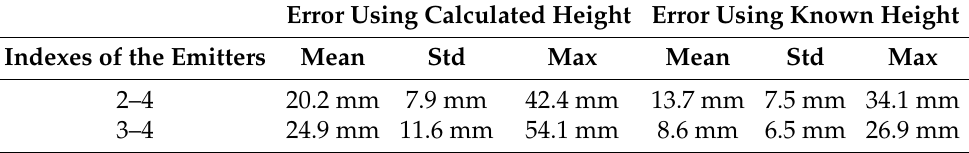
Table 2. Positioning errors using two emitters obtained by a weak calibration procedure.